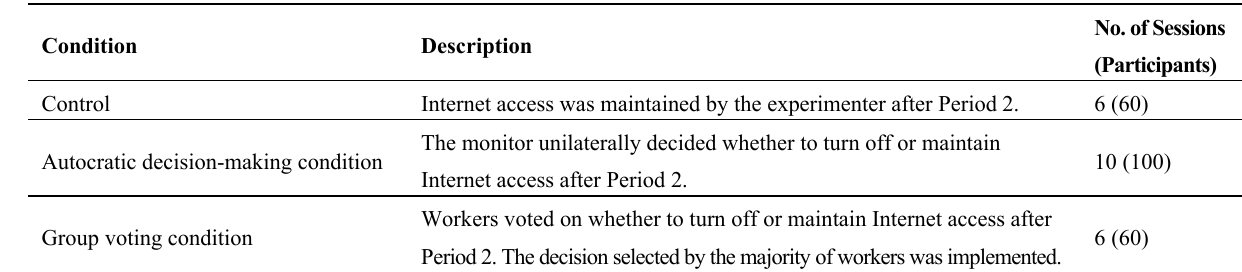
Table 1. Summary of